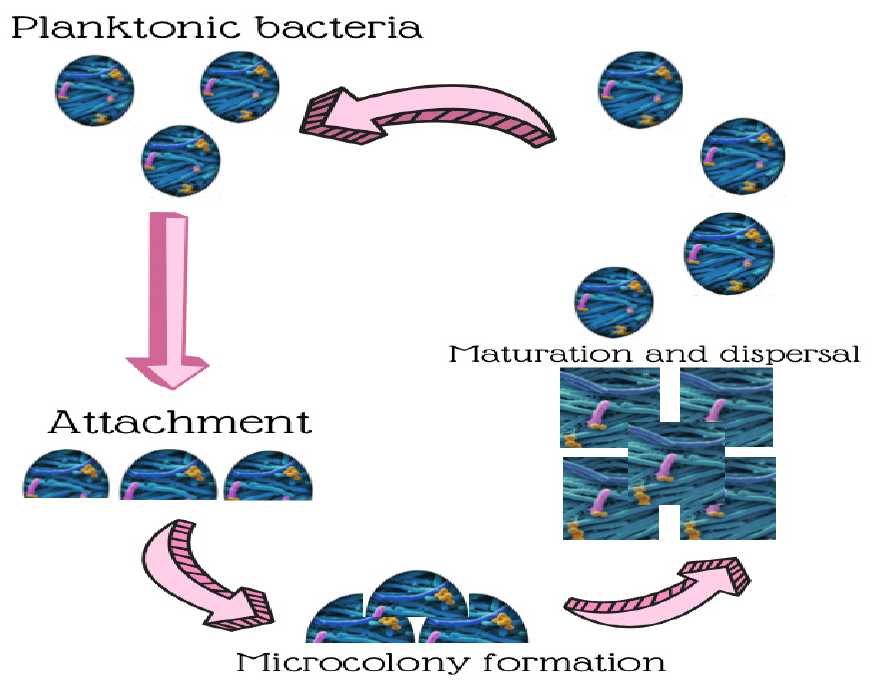
Figure 1. Biofilm formation and development stages.